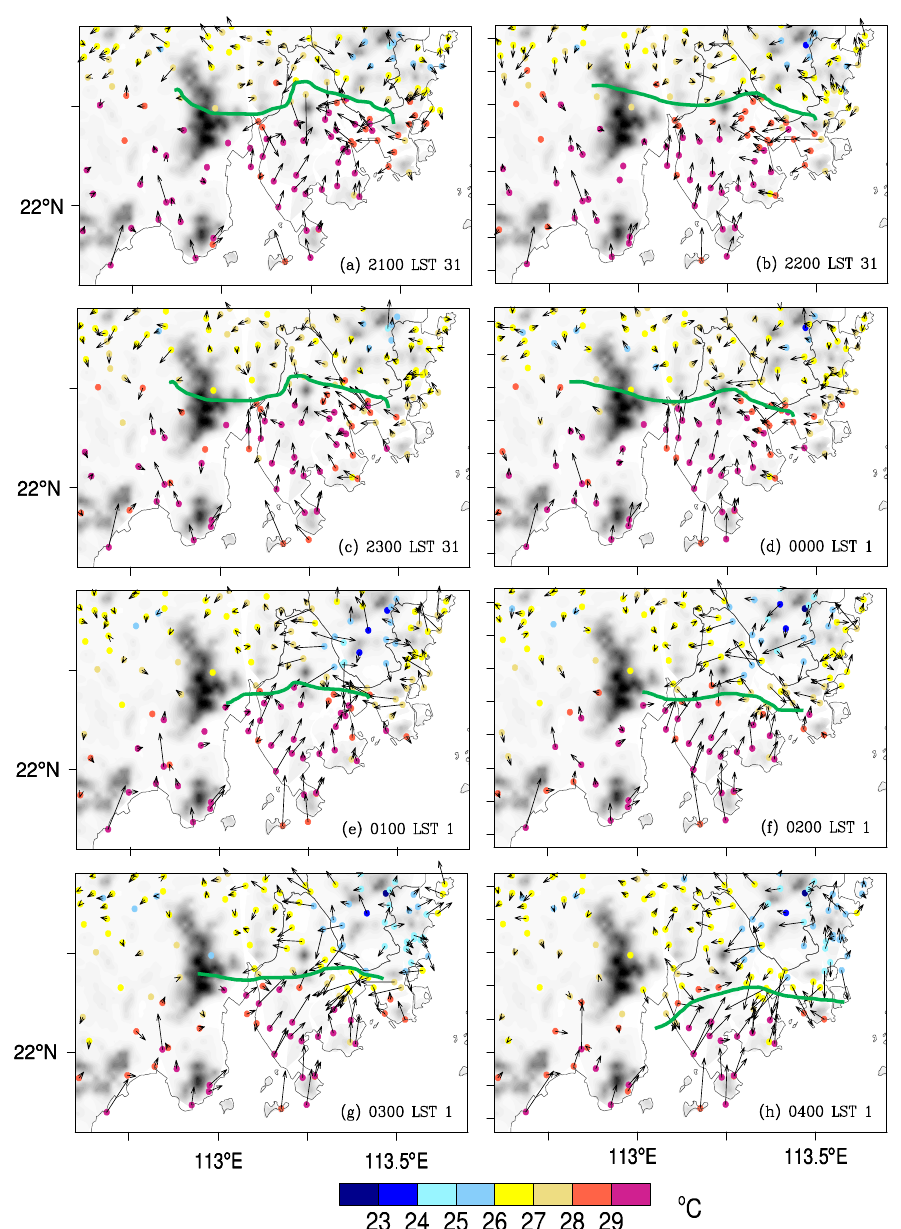
Figure 4. Temperature (colored dots; unit: °C) and winds (vector) observed by AWSs at ( a ) 2100 LST 31, ( b ) 2200 LST 31, ( c ) 2300 LST 31, ( d ) 0000 LST 1, ( e ) 0100 LST 1, ( f ) 0200 LST 1, ( g ) 0300 LST 1, ( h ) 0400 LST 1. Green solid line represents the position of mesoscale convergence line. Terrain is shaded in gray as in Figure 1b.